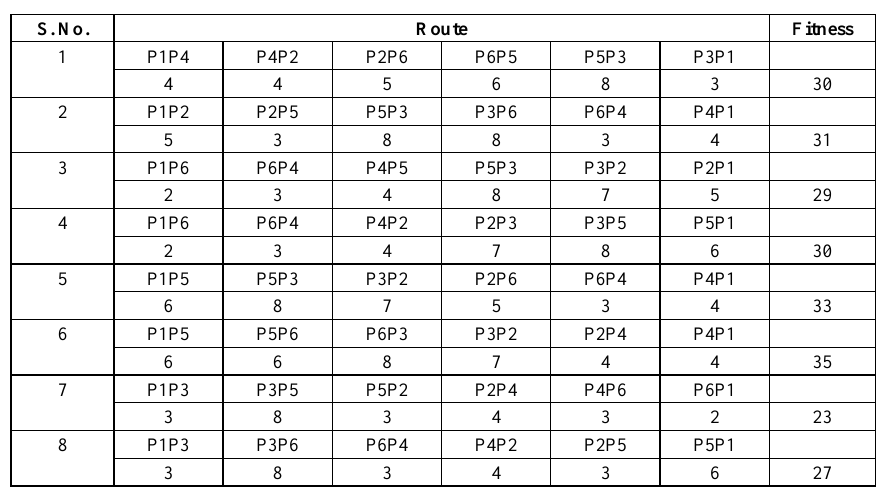
Calculate Fitness value after